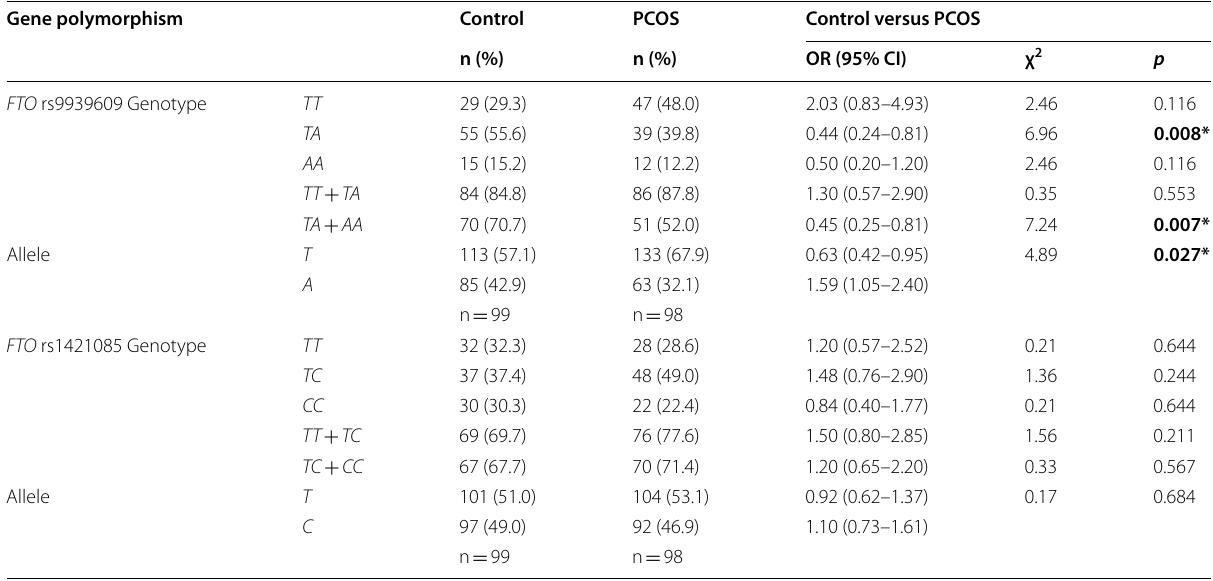
Table 3 Genotype and allele frequencies of FTO rs9939609 (T>A) and FTO rs1421085 (T>C) variants in PCOS patients and